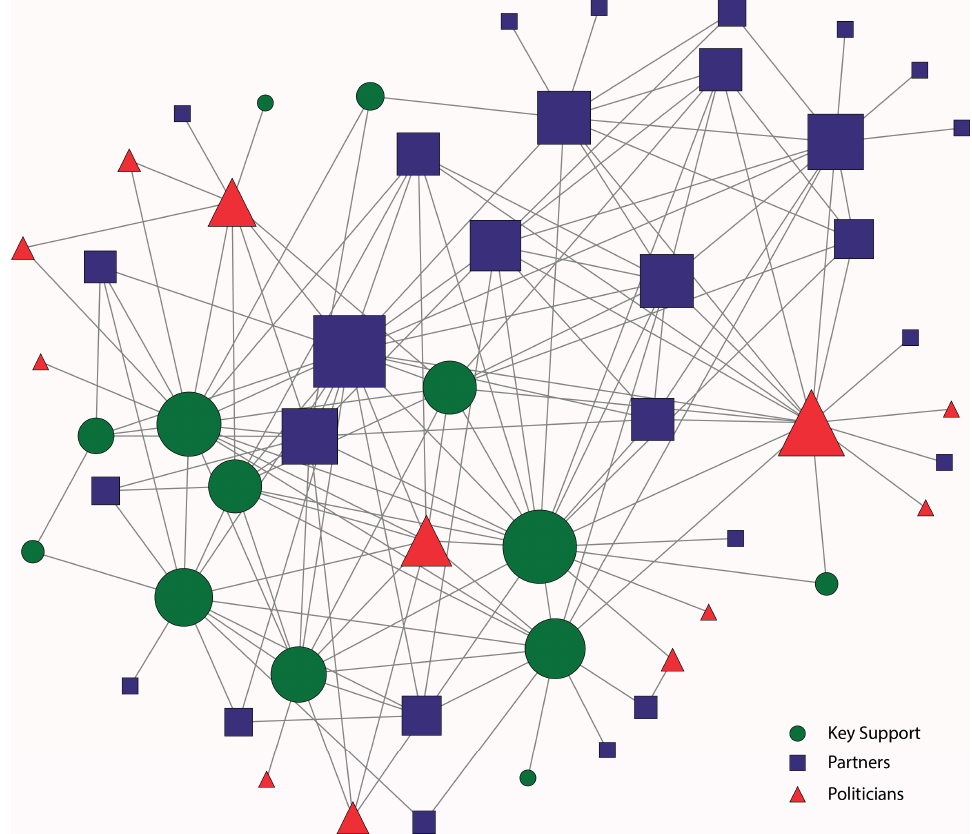
Figure 2. Kansas City Smokefree Policy Contact network. Nodes were sized by the number of individuals they had contact